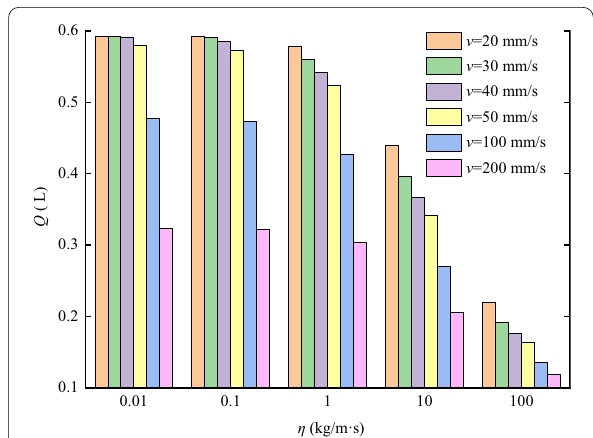
Figure 12 The influence curve of the sediments dynamic viscosity on the coring volume